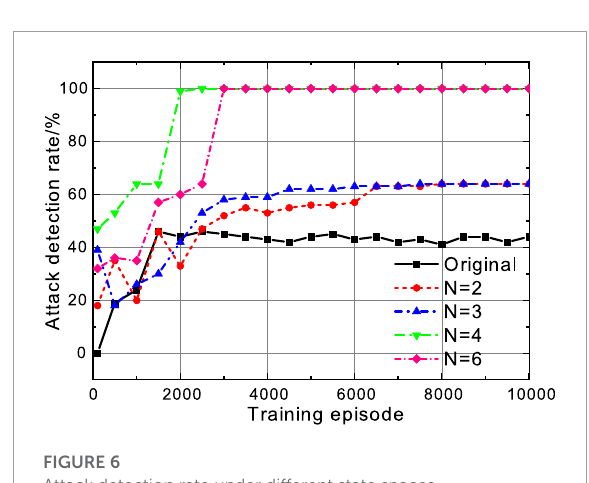
FIGURE 6 Attack detection rate under different state